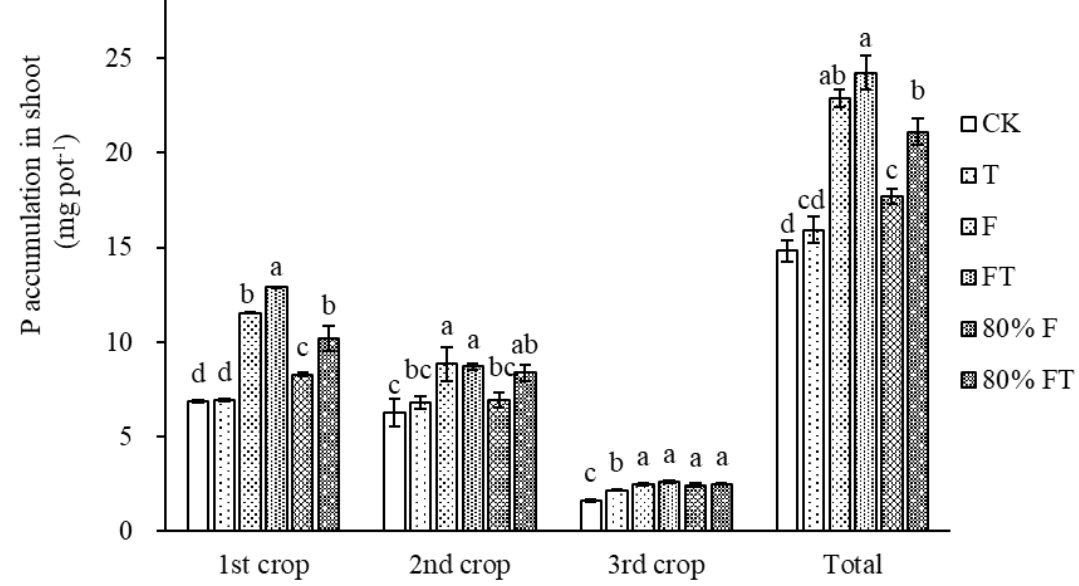
Figure 4. Effect of the preparation on phosphorous accumulation in the shoots. Values were expressed as means (n = 4) ± SE. Different letters within the same crop indicate significance at the 5% level.